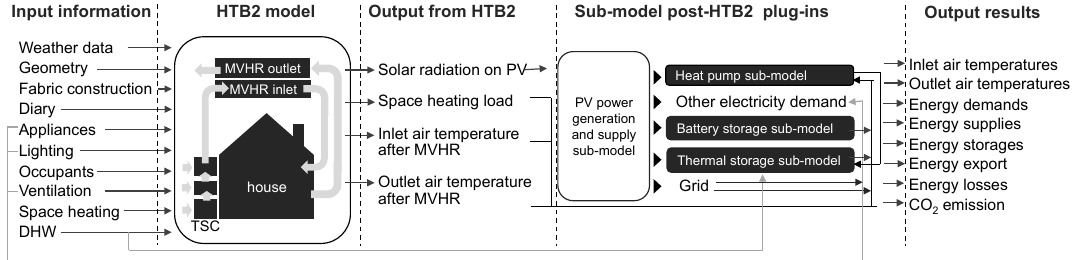
Figure 4. Schematic diagram for simulating the integrated system approach for the SOLCER energy-positive house.